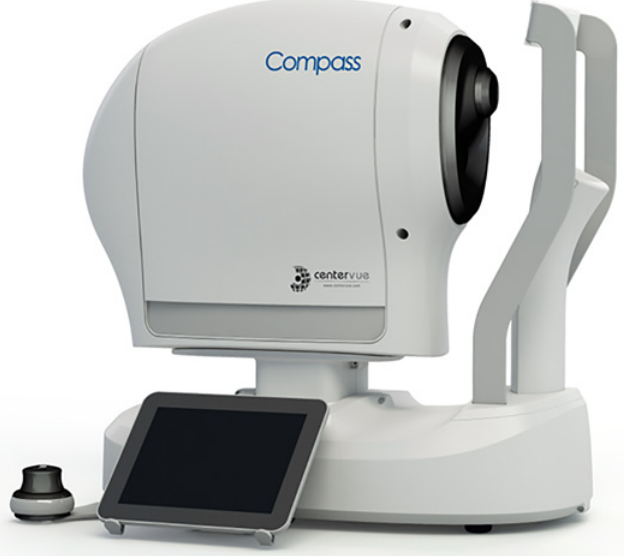
Fig 1. Compass automated fundus perimeter, with tablet and joystick